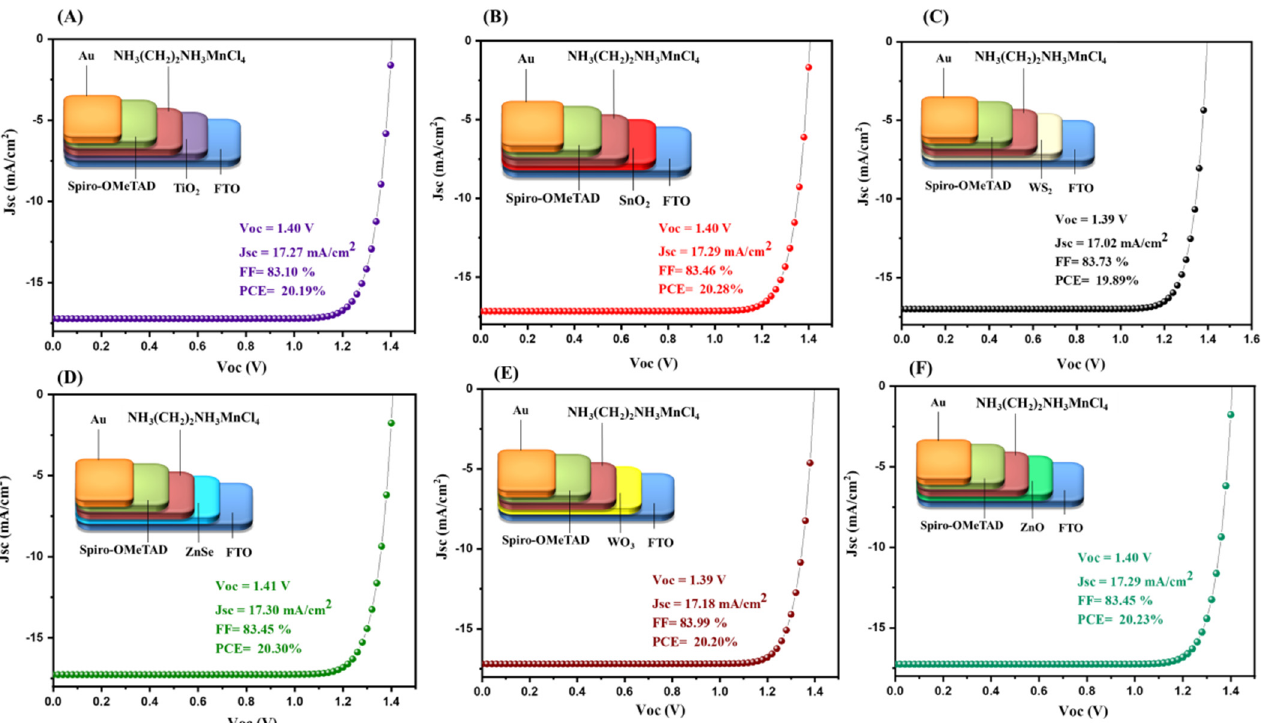
Figure 5. J-V curves ( A – F ) of FTO/ETL (50 nm)/NH 3 (CH 2 )NH 3 MnCl 4 (600 nm)/Spiro-OMeTAD Figure 5. J ‐ V curves ( A – F ) of FTO/ETL (50 nm)/NH 3 (CH 2 )NH 3 MnCl 4 (600 nm)/Spiro ‐ OMeTAD (300 nm)/Au. (300